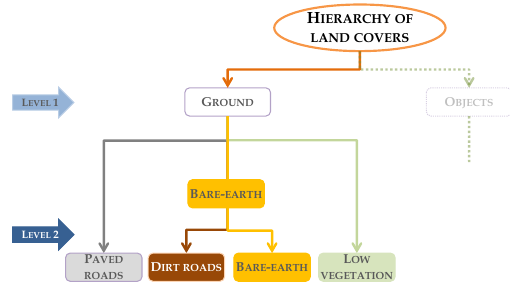
Figure 4. Hierarchy of ground cover